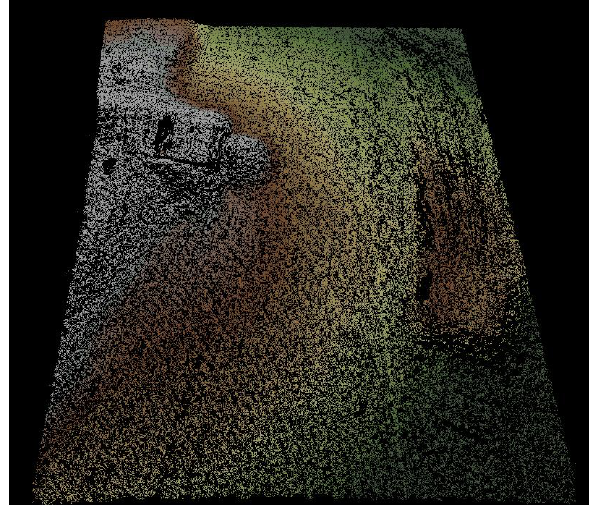
Fig. 4: DSM generated from UAV images. The illustration shows the matched points, colour-coded from green (548 m above sea level) to grey (556 m above sea level), the width of the area of interest is ca. 39